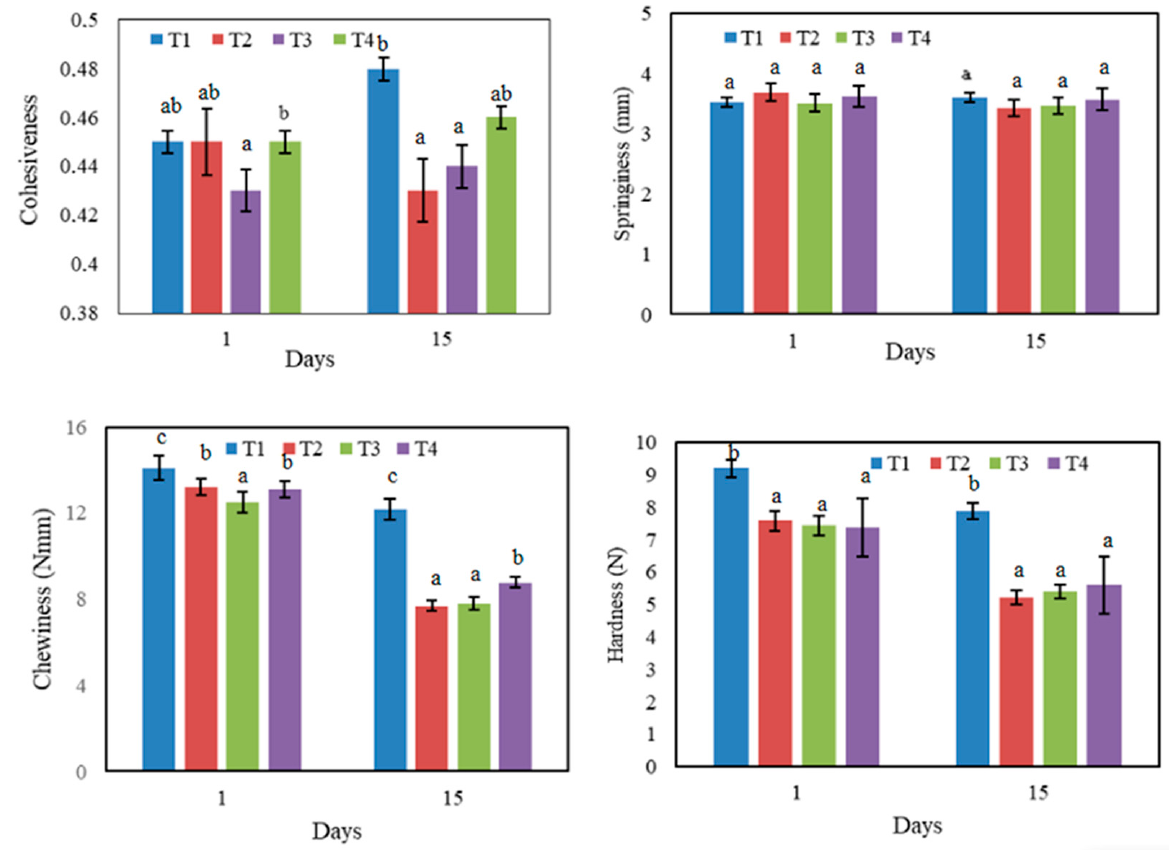
Figure 4. TPA parameters of different sausages during refrigerated storage. a, b, c: Different letters are significantly different p < 0.05 between formulations. Table 2. Color parameters (L*, a*, b*) of sausages during refrigerated storage. Color